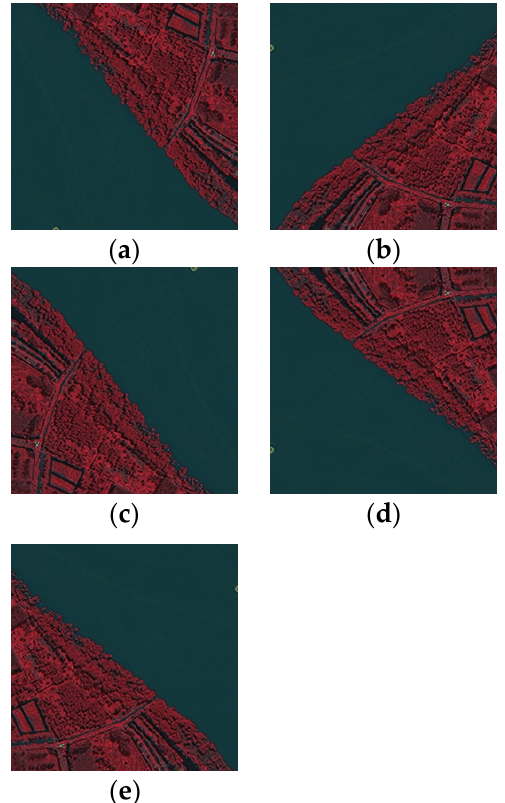
Figure 8. Example of remote sensing images by data augmentation. ( a ) 90° rotation; ( b ) 180° rotation;